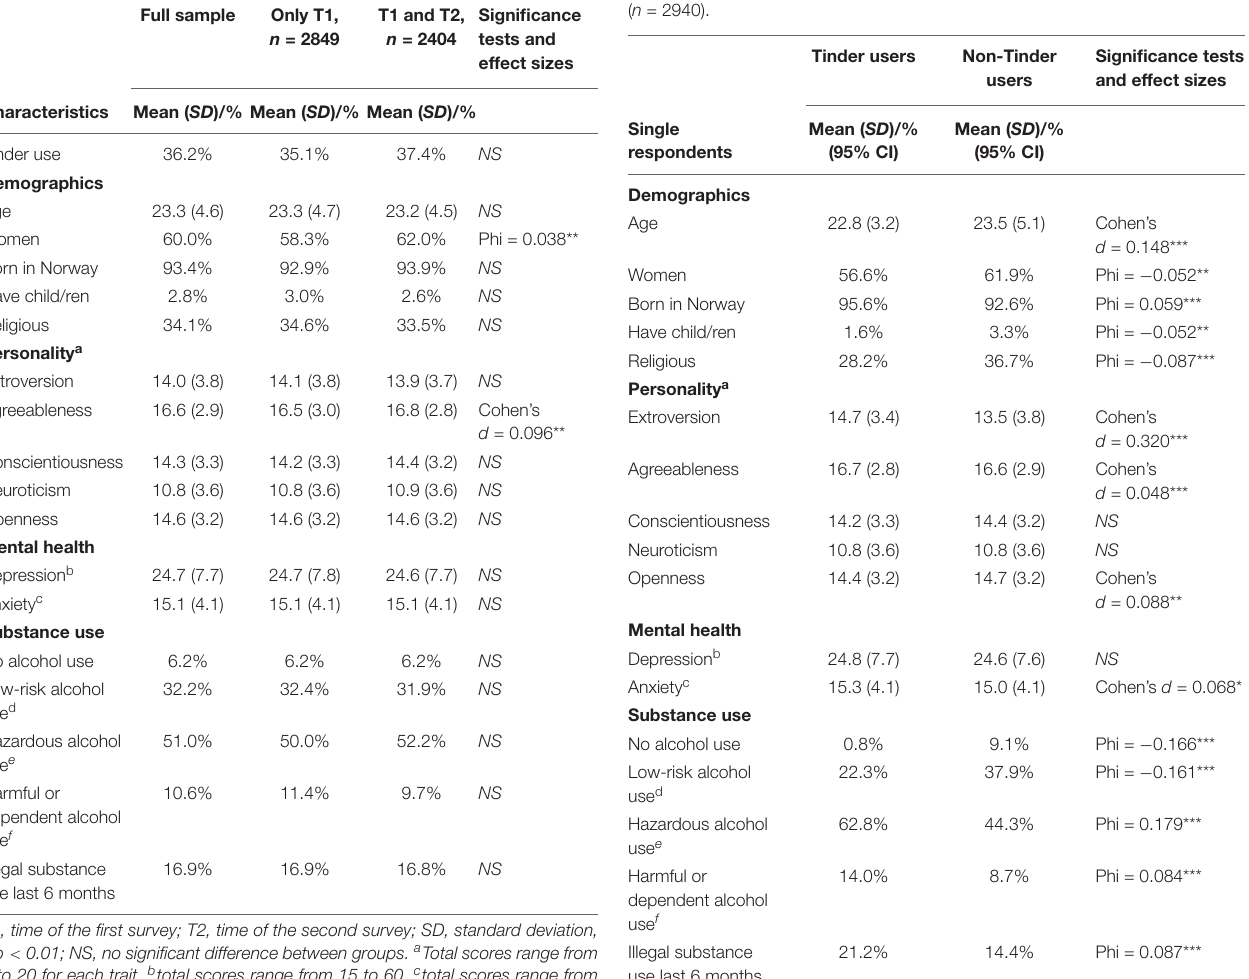
TABLE 1 | Sample characteristics and dropout analysis, N = 5,253. TABLE 2 | Distribution of demographic, personality, mental health, and substance